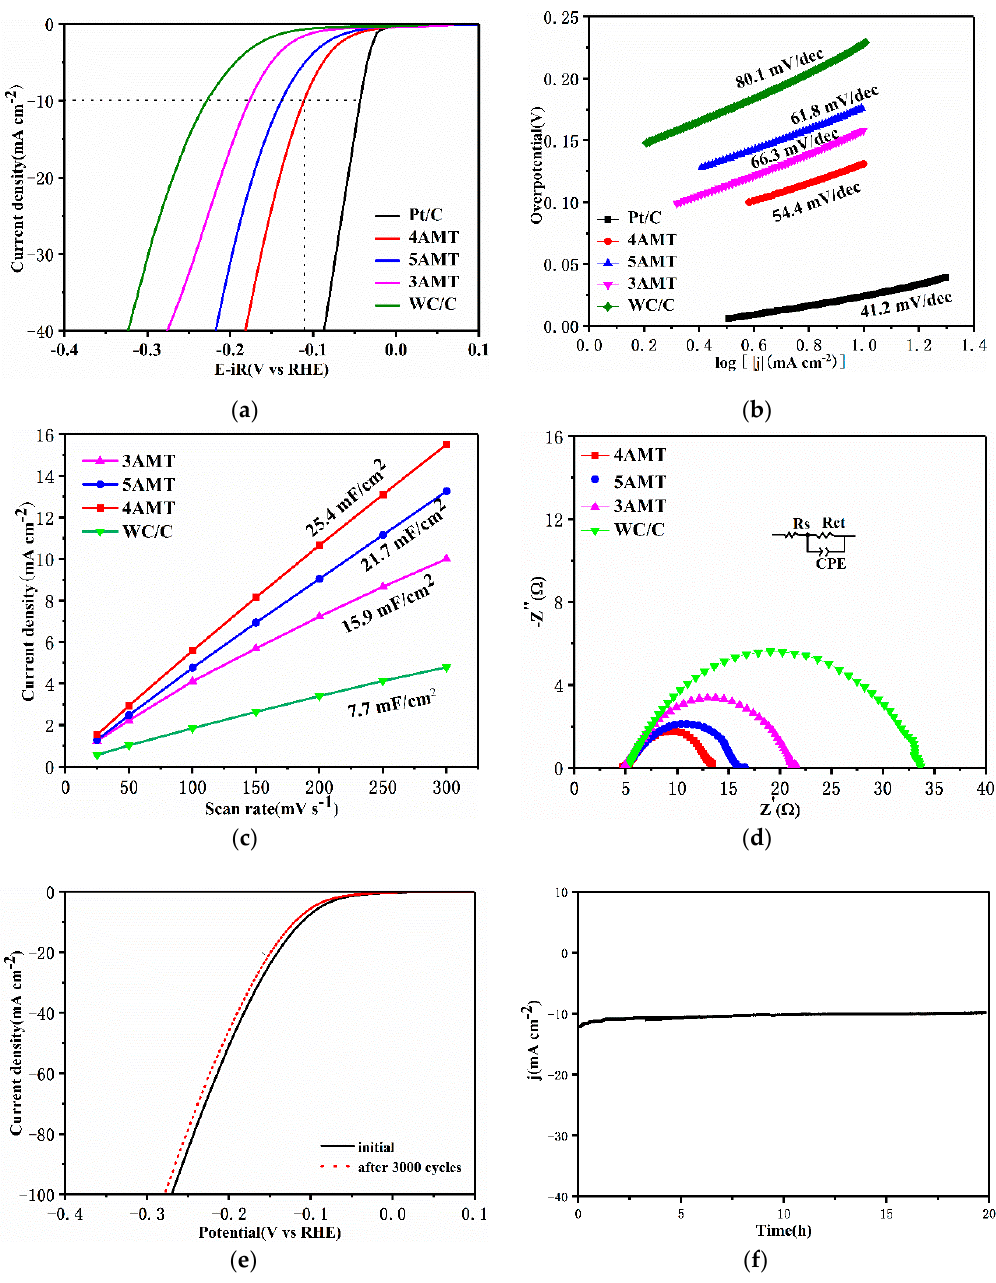
Figure 4. ( a ) LSV curves of 4 AMT, 5 AMT, 3 AMT, WC/C, and Pt/C in 0.5 M H 2 SO 4 ; ( b ) Tafel slopes generated from ( a , c ) C dl of 4 AMT, 5 AMT, 3 AMT, and WC/C; ( d ) EIS curves of 4 AMT 5 AMT, 3 AMT, and WC/C (insertion is the equivalent circuit); ( e ) LSV curve of 4 AMT after 3000 CV cycles; ( f ) i-t curve of 4 AMT with an overpotential of 120 mV.